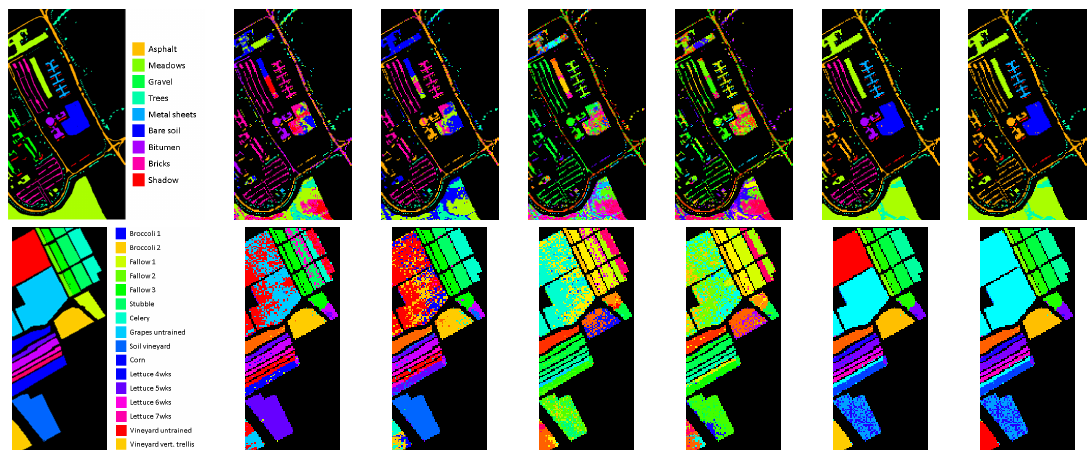
Figure 5. Map of different classes within the data (each colour corresponds to a different class/cluster of pixels). From left to right: Ground truth, results of FDPC, GWENN, FINCH, LPC, K-MBC and MBC. Top to bottom: Pavia University and Salinas scenes. Note: cluster colours were selected to maximise the number of pixels with the same colour as in the ground